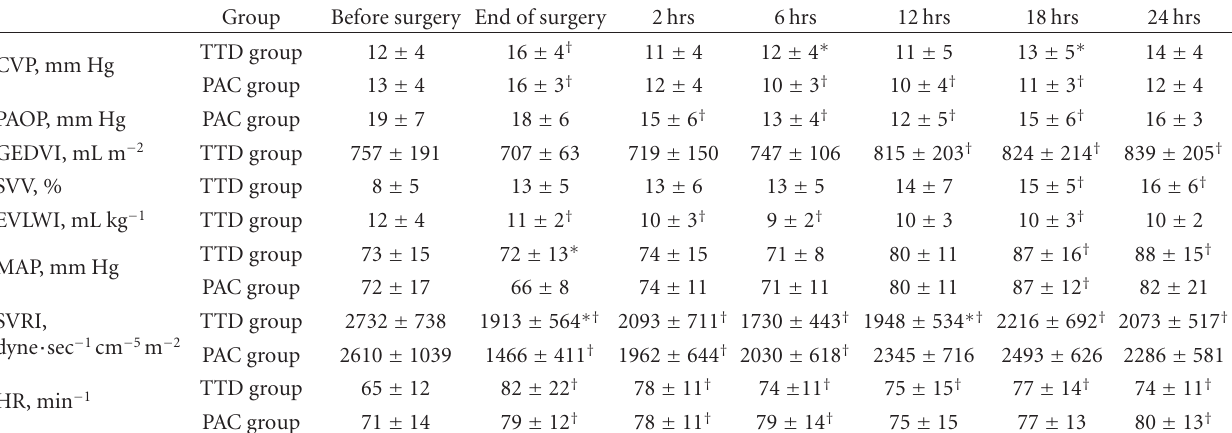
Table 2: Changes in hemodynamic parameters in the study groups.